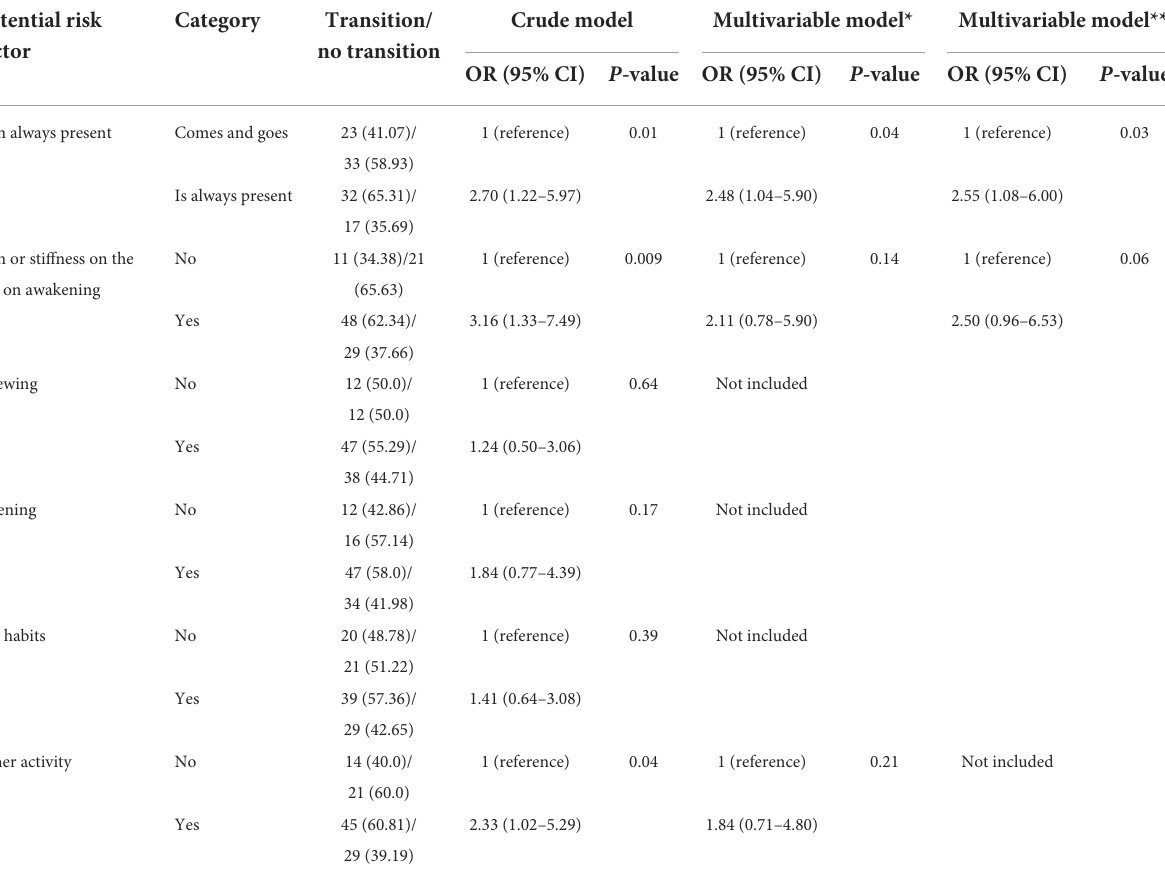
TABLE 5 Binary logistic regression analyses assessing the association between TMD-Pain screener items and the acute to chronic transition at 3 months of follow-up. Potential